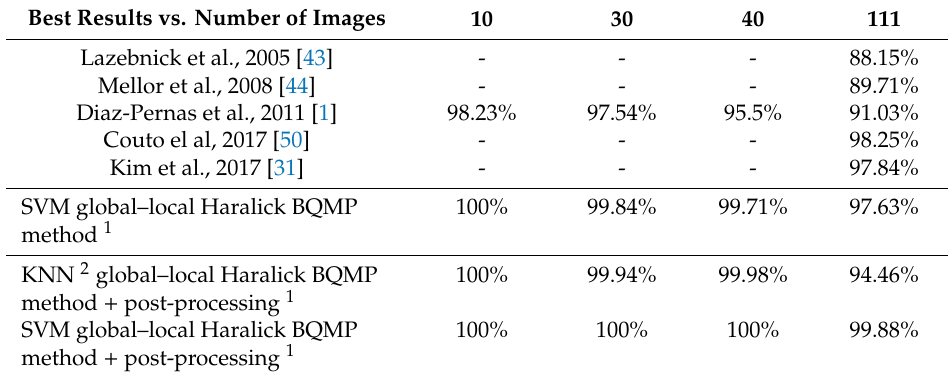
Table 2. Best results of global–local Haralick– binary quaternion-moment-preserving (BQMP) classification for the Brodatz database for the four sets of 10, 30, 40, and 111 images compared to previously published studies. SVM—support vector